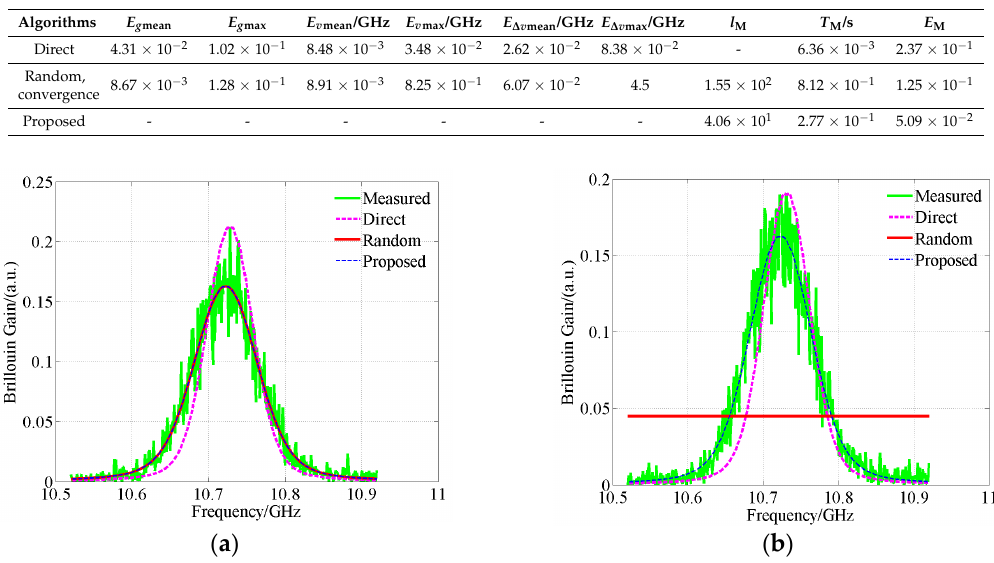
Table 10. Statistical results of errors in the extracted key parameters, computation time, iteration number and sum of the squared normal distances corresponding to three Voigt profile-based algorithms, measured signals with average number of 2 10 .